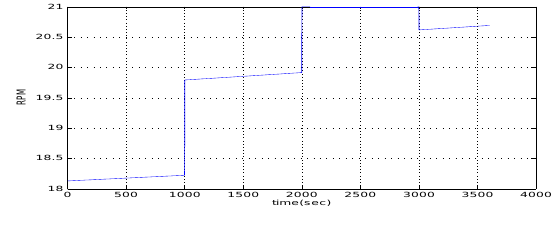
Figure 6: Manipulated RPM.